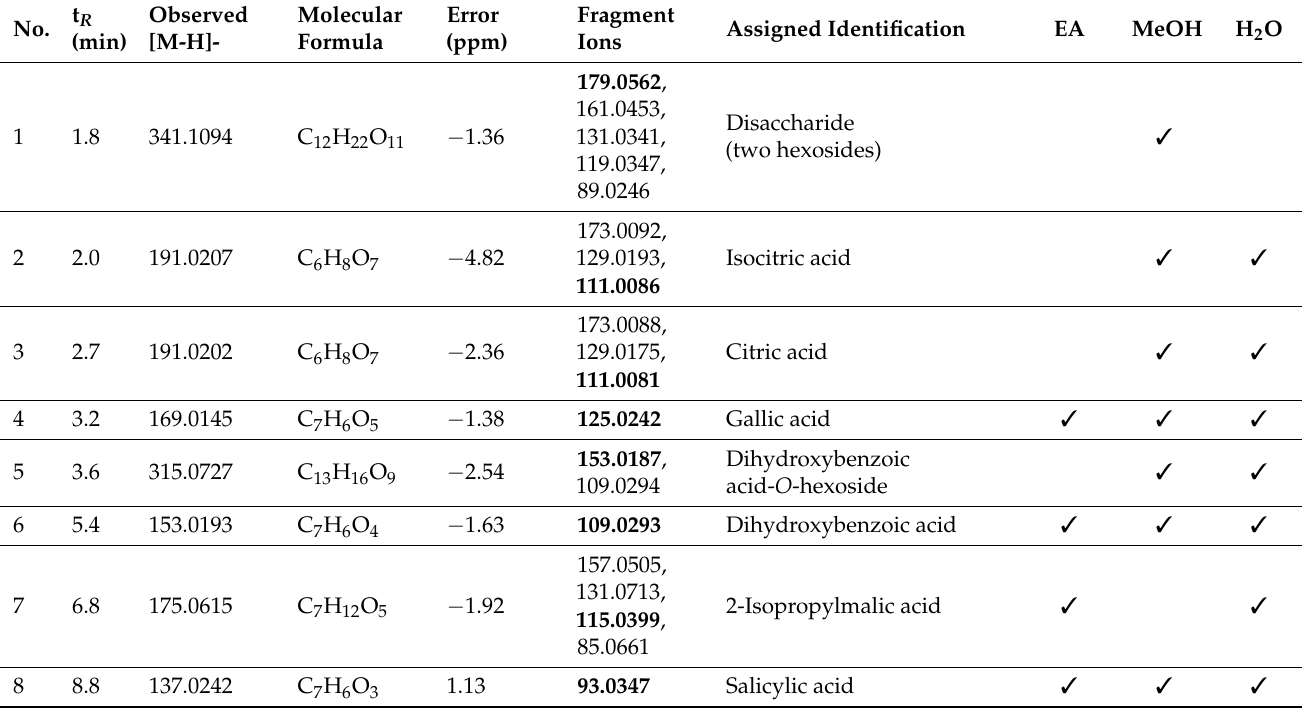
Table 2. Characterization of the compounds found in the analyzed extracts of R. madagascariensis